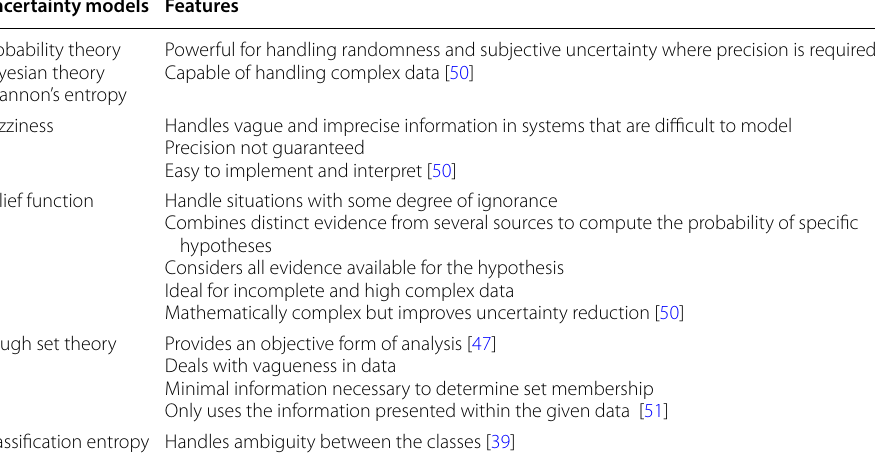
Table 1 Comparison of uncertainty strategies Uncertainty models